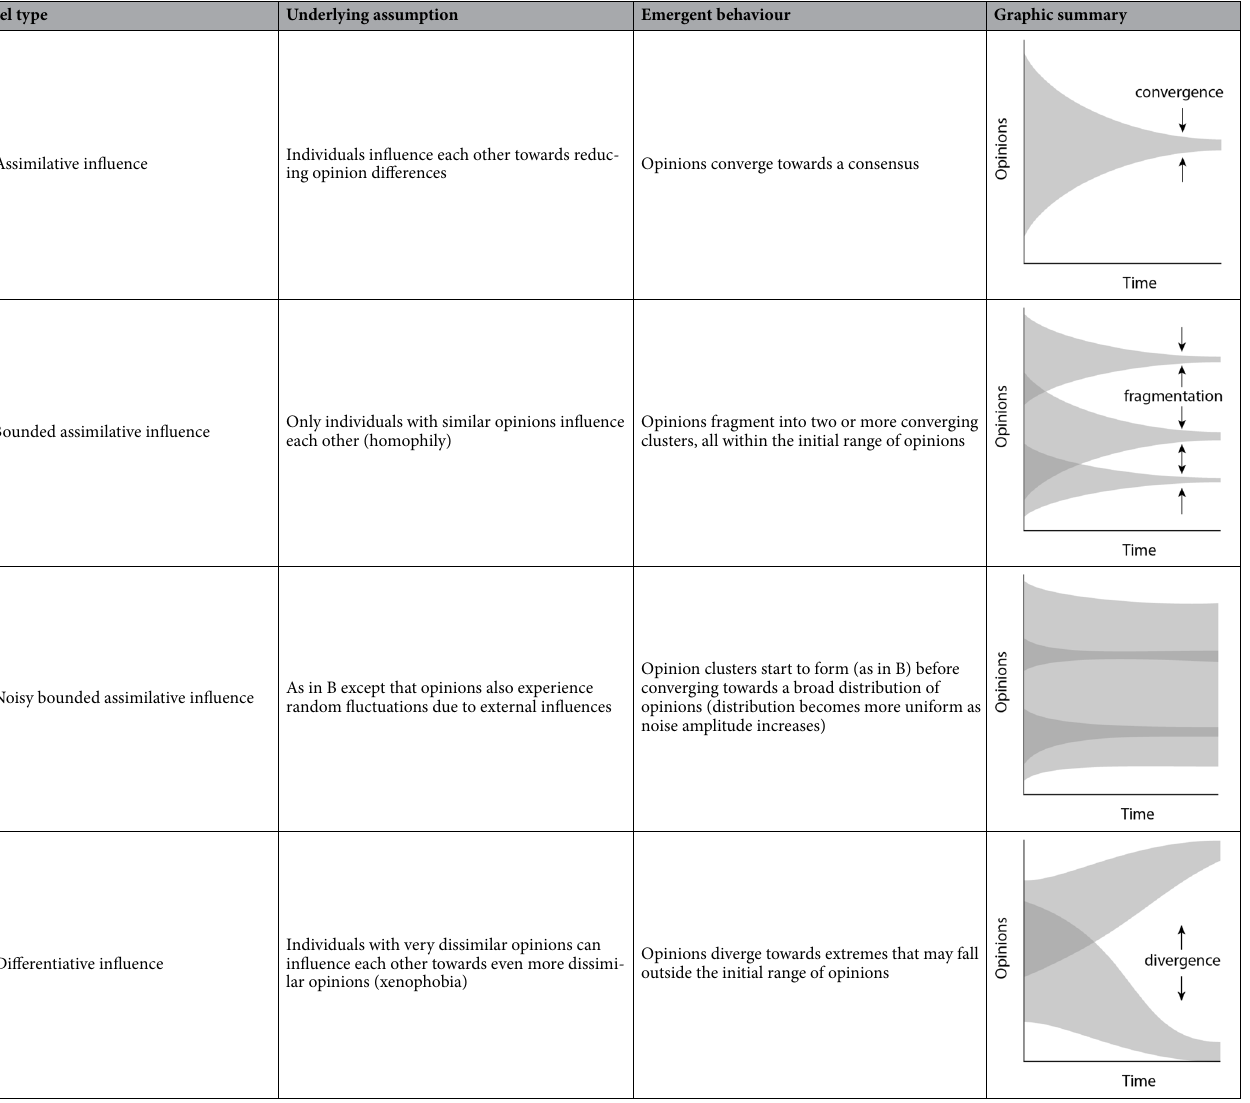
Table 1. Social influence model types, underlying assumptions and emergent